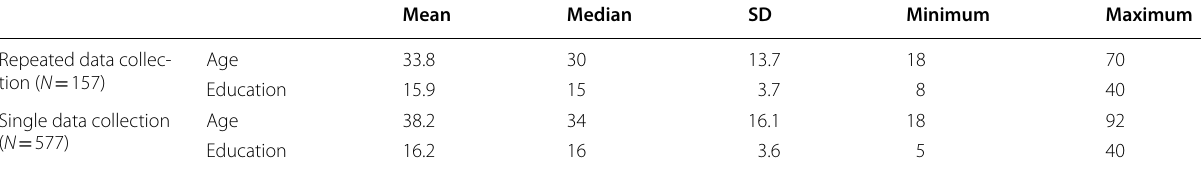
Table 1 Summary of the descriptive statistics of the repeated and single data